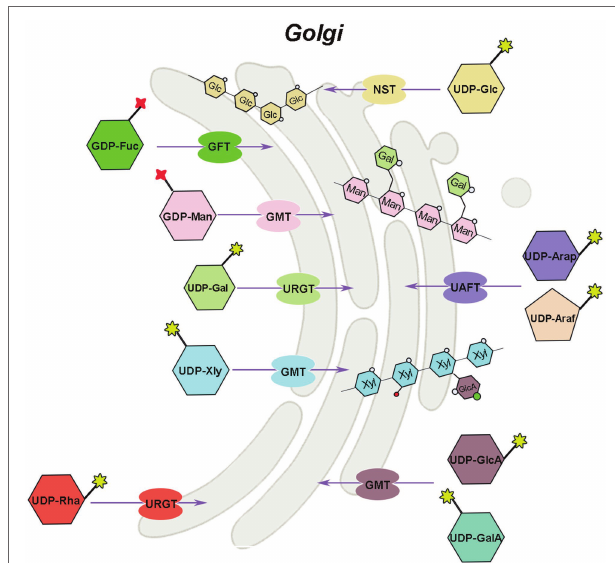
FIGURE 3 | Mechanism of hemicellulose substrate transport. UTR, UDP- galactose/UDP-glucose transporter; URGT, UDP-Rha/UDP-Gal transporter; UAFT, UDP-arabinofuranose transporter; UXT, UDP-Xyl transporter; UAfT, UDP-Araf transporter proteins; GFT, GDP-fucose transporter; GMT, GDP- mannose